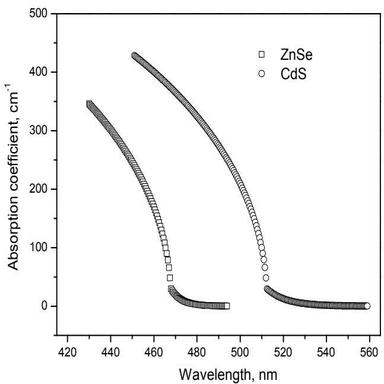
The absorption coefficient spectra of the ZnSe and CdS crystals used in Eq.